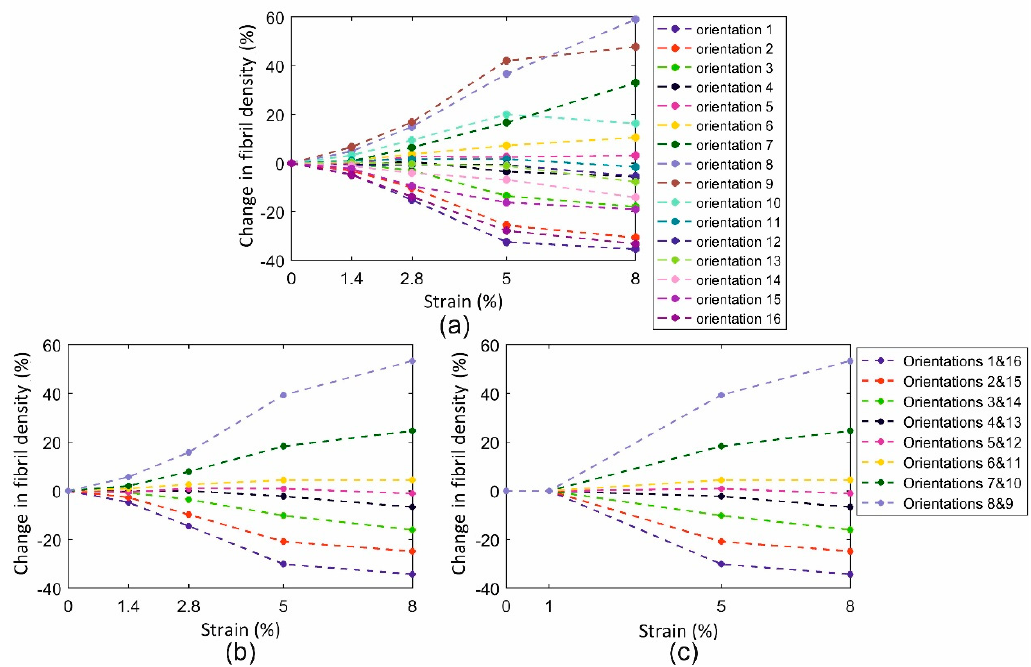
Figure 7. Fibril reorientation with strain increase up to 8%. ( a ) Mean results obtained experimentally for 16 orientations, ( b ) results shown while considering symmetry on opposite sides of the axial direction, ( c ) simplified reorientation behaviour to improve the stability of numerical models. ( b ) and ( c ) share the same legend.